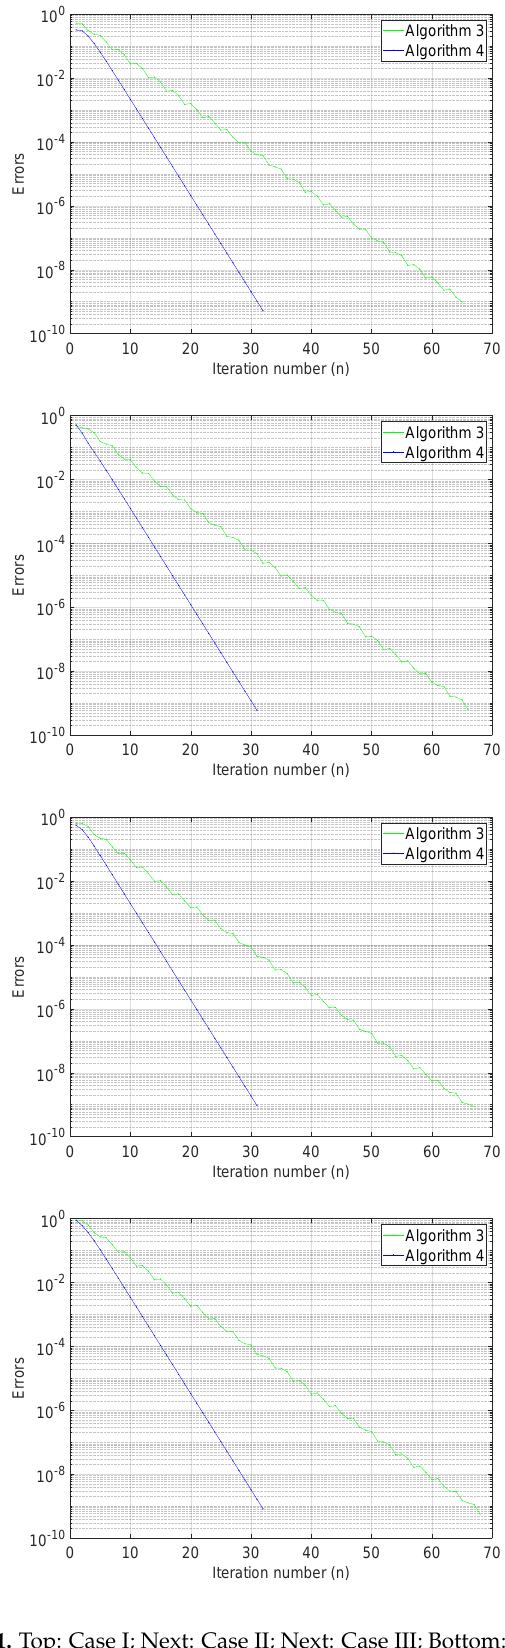
Figure 1. Top: Case I; Next: Case II; Next: Case III; Bottom: Case IV.